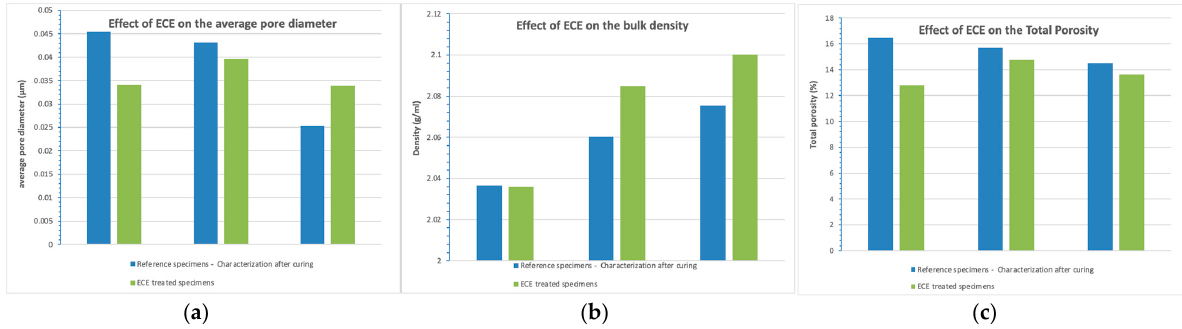
Figure 14. Influence of binder type in the pore structure before and after ECE treatment. ( a ) Average pore diameter; ( b ) bulk density; ( c ) total porosity.